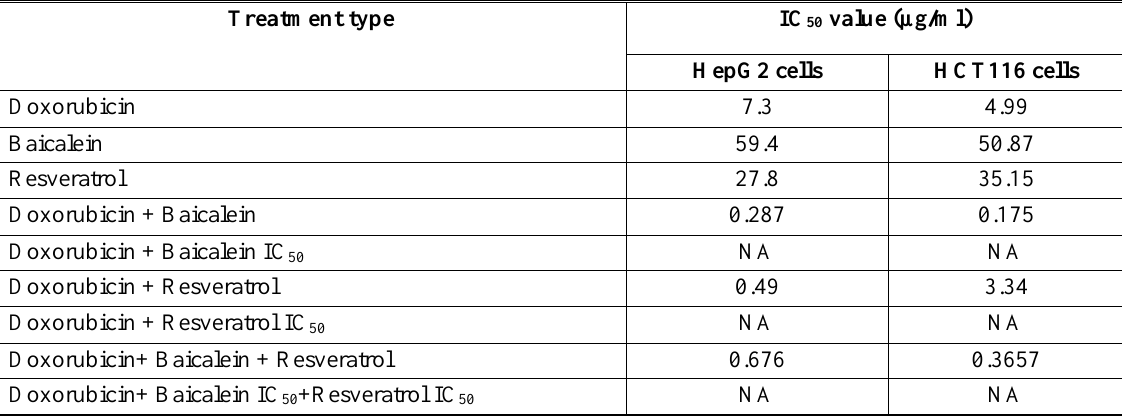
Table 1. IC 50 values of individual drugs and their combination treatment on HCT116 and HepG2 cell lines. Treatment